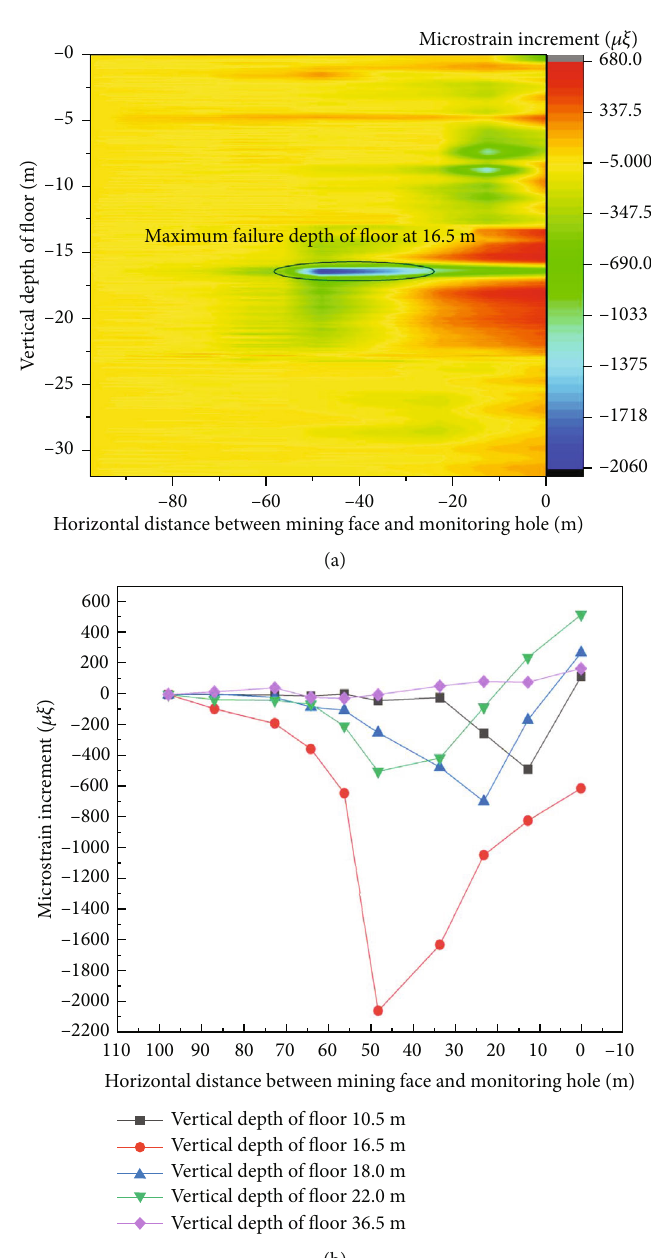
Figure 12: Strain cloud map of hole 2#(a) and strain curve of measuring point in hole 2#